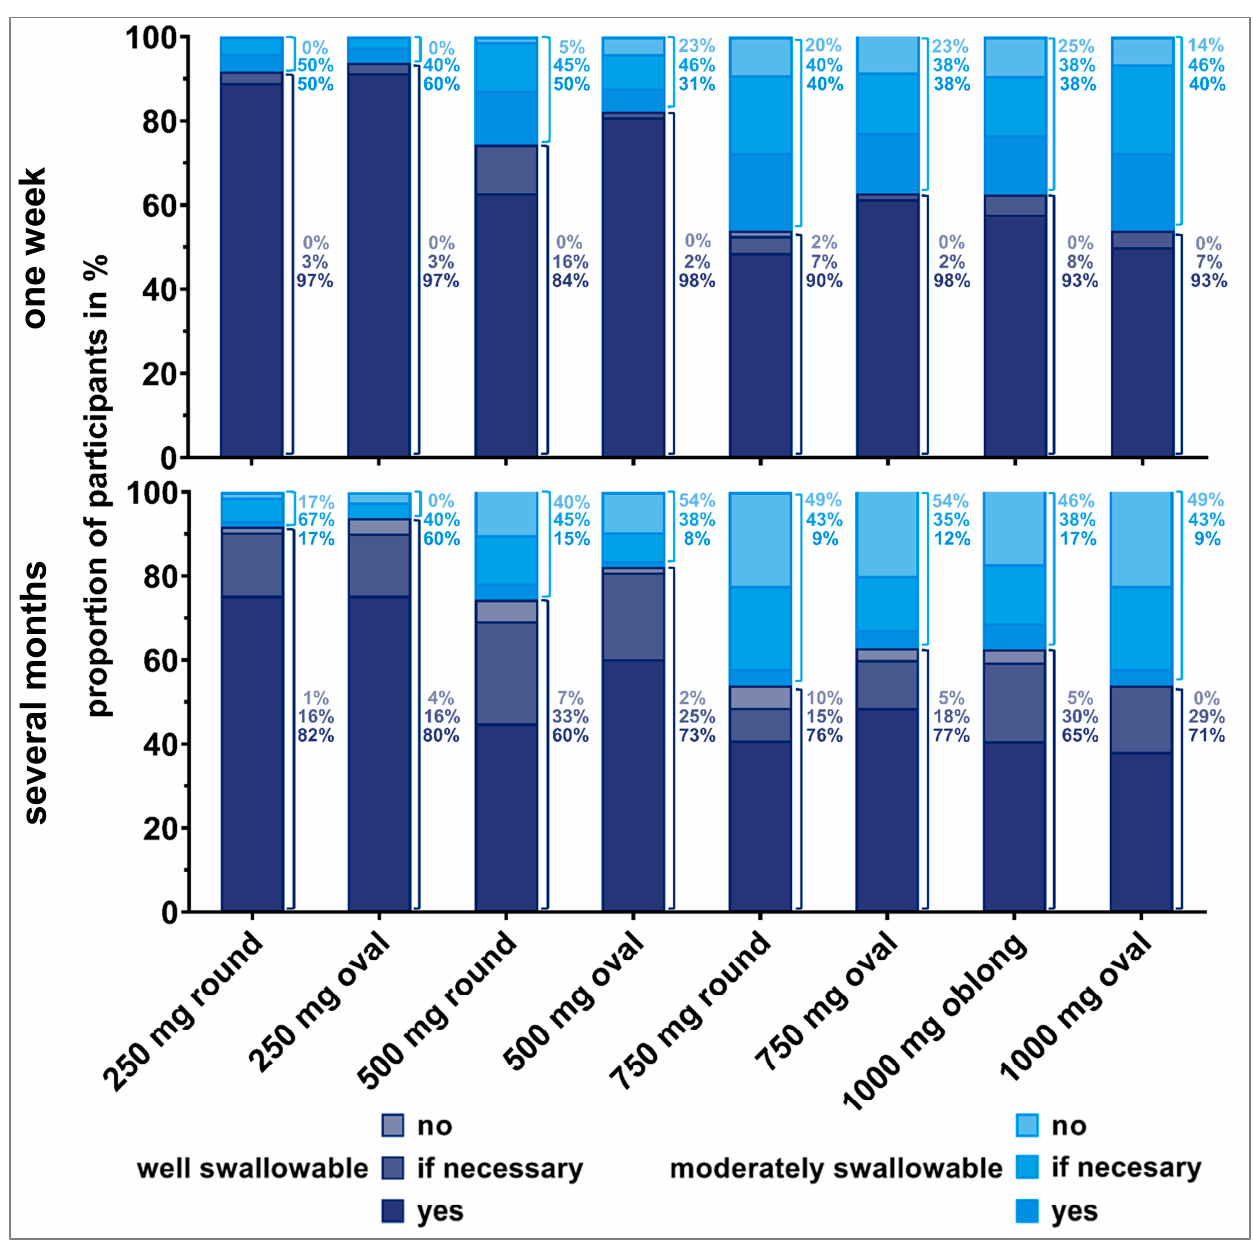
Figure 5. Willingness ( no , if necessary , yes ) of old participants to swallow the respective tablet once a day for one week (upper panel) or over several months (lower panel), dependent on tablet’s swallowability rating. Only the answers from participants who were able to swallow the tablets were considered here (corresponding to 100% value). Thus, zero to three evaluations from each participant are included. Percentages to the right of the bars are representing the fractions of the different willingness levels, if all deglutition attempts of each swallowability rating ( well or moderately swallowable ) are set to